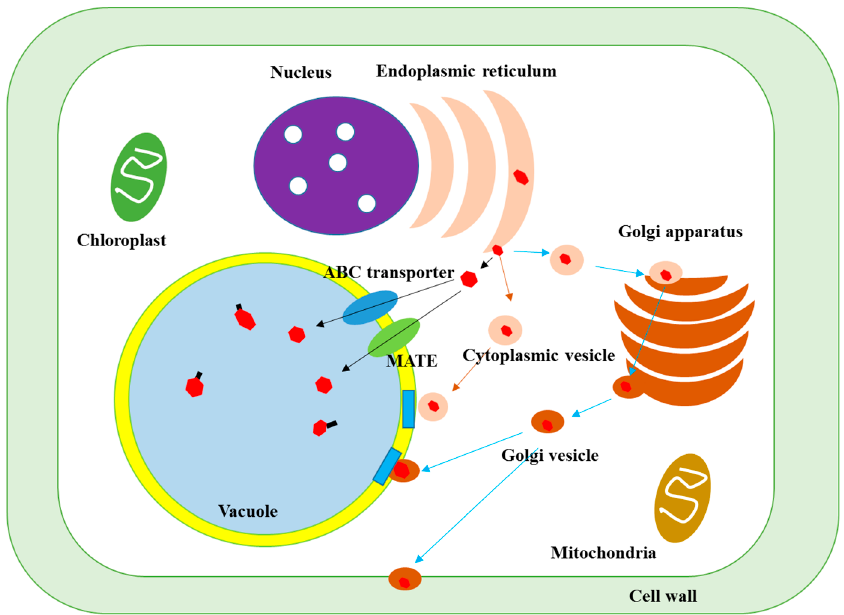
Figure 3. Transfer mechanisms of phenolics after synthesis at the endoplasmic reticulum in plant cell. (ABC: ATP-binding cassette; MATE: multidrug and toxic compound extrusion).